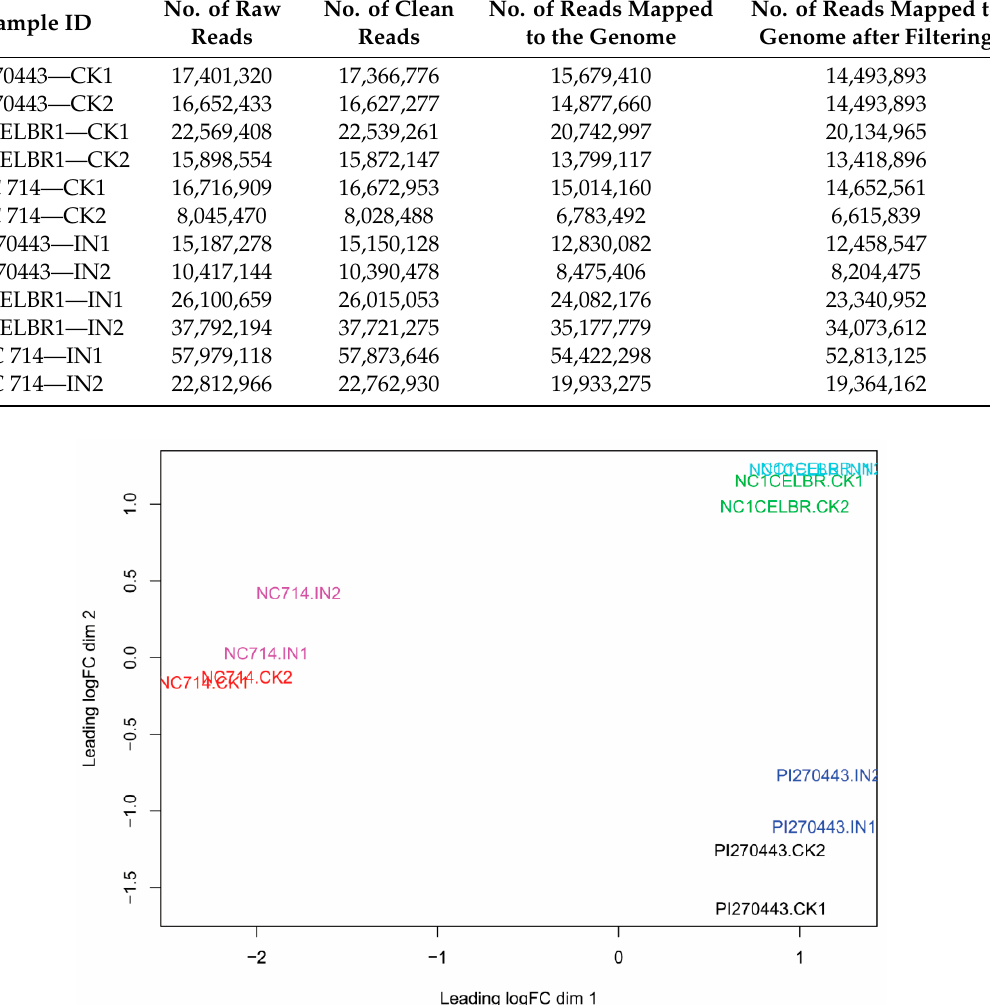
Figure 2. Multidimensional scaling plot for the relationship of each RNA-Seq library. Distance between libraries was calculated as the leading log fold change for biological variation between libraries [23]. The label of “IN” represents BS-inoculated samples, and “CK” represents a control sample without inoculation of